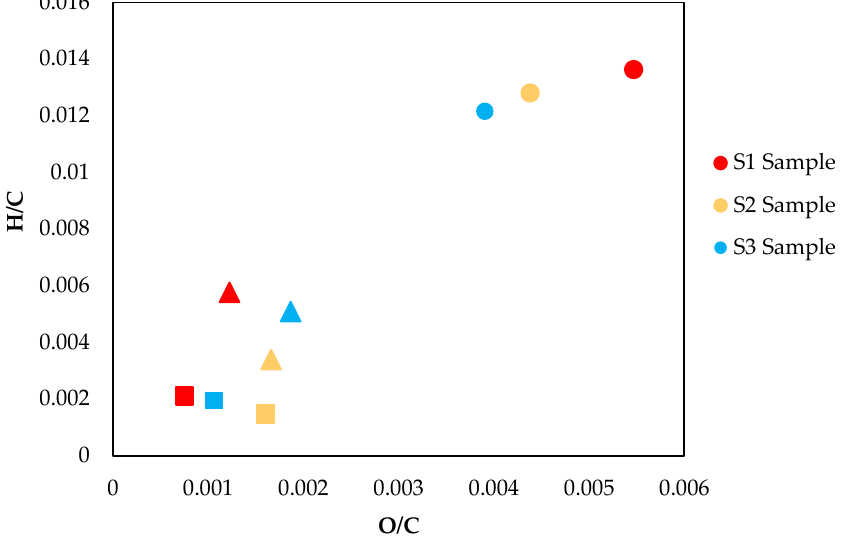
Figure 3. Van Krevlen diagram for biosolids (●) and biochars at 500 °C ( ▲ ) and 700 °C ( ■ ) .